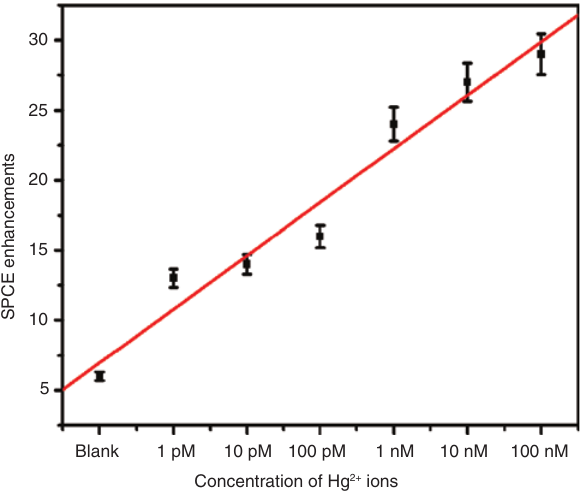
Figure 2: Concentration plot indicating SPCE enhancements for dif- ferent Hg 2 +